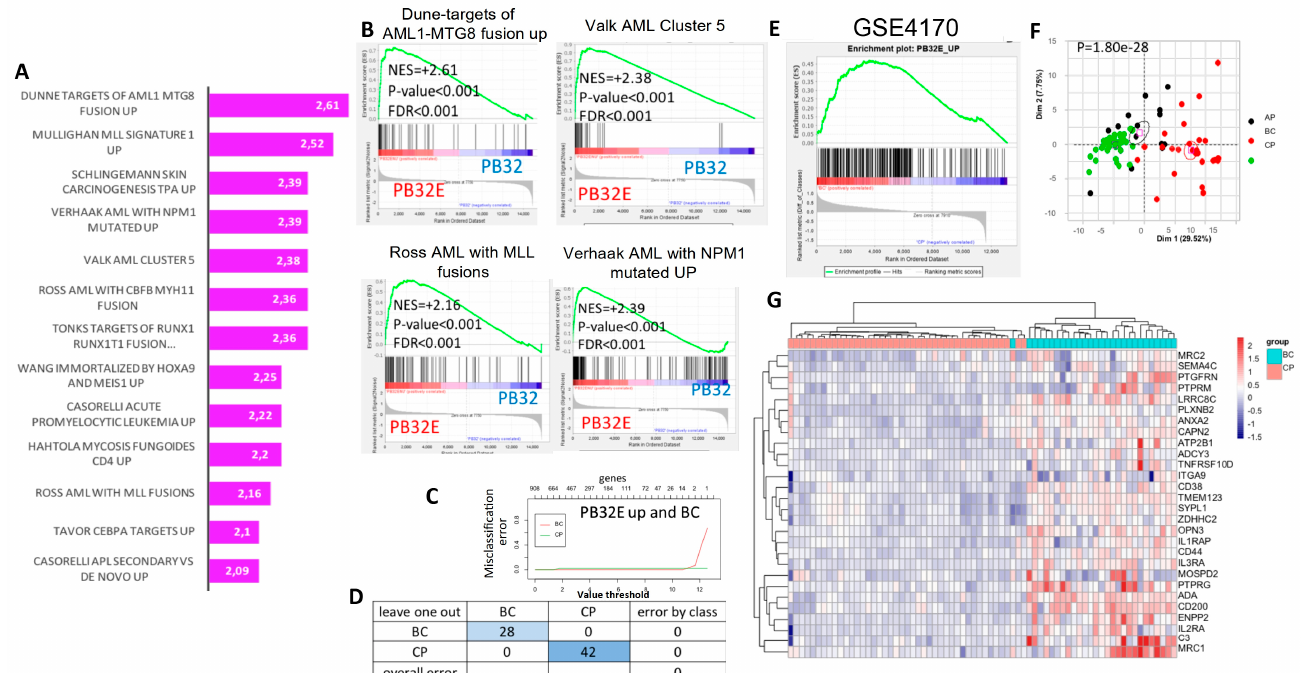
Figure 6. Blast-enriched signatures by ENU on PB32 CML-iPSCs differentiated into hematopoiesis ( A ) Bar plot of GSE analysis between ENU and control condition for PB32 performed on C MSigDb database. ( B ) Representation of AML GSE plot enriched signature on PB32 and PB32-ENU (PB32E). ( C ) Predictive signature for stratification of hematopoietic progenitors from CML patients in blast crisis as compared with ones from CML patients in the chronic phase. ( D ) Misclassification error. (E) Integration of PB32-ENU signature on GSE4170. ( F ) Unsupervised principal component analysis was performed with PB32-ENU-upregulated genes on HP of the distinct CML disease phase. ( G ) Upregulated receptors highlighted by integrative analysis during blast crisis.